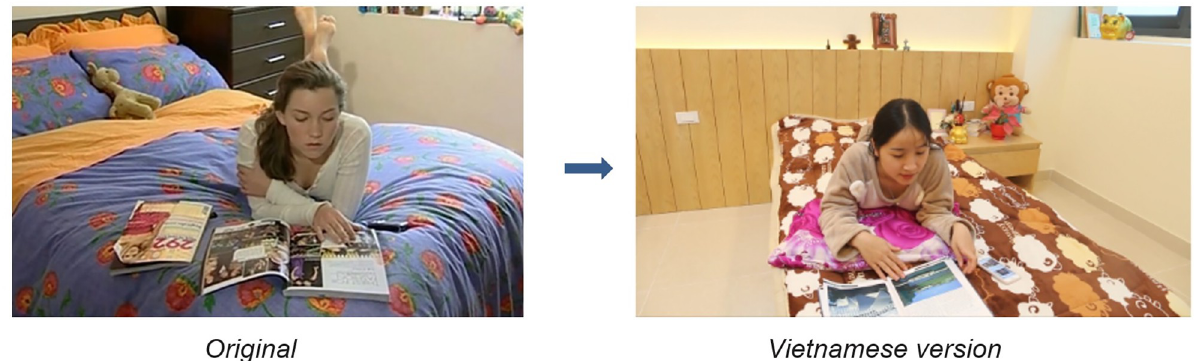
Fig 3. The original and Vietnamese actresses in the Saskia video. Reprinted from the RAP-A and Happy House videos under a CC BY license, with permission from Astrid Wurfl, original copyright 2021.